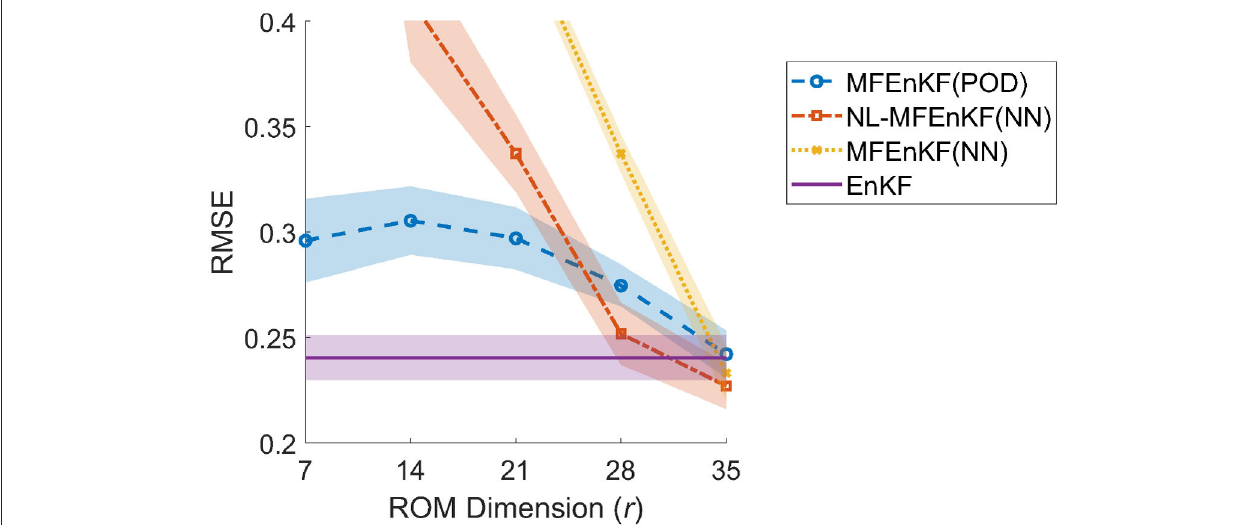
FIGURE 3 | Lorenz’96 analysis RMSE vs. ROM dimension ( r ) for three multifidelity data assimilation algorithms and the classical EnKF. Ensemble sizes are N X = 32 and N U = r − 3. Error bars show two standard deviations. The inflation factor for the surrogate ROMs is fixed at α U = 1.01, the inflation of α = 1.07 is used for the EnKF, and α X = 1.05 is used for all other